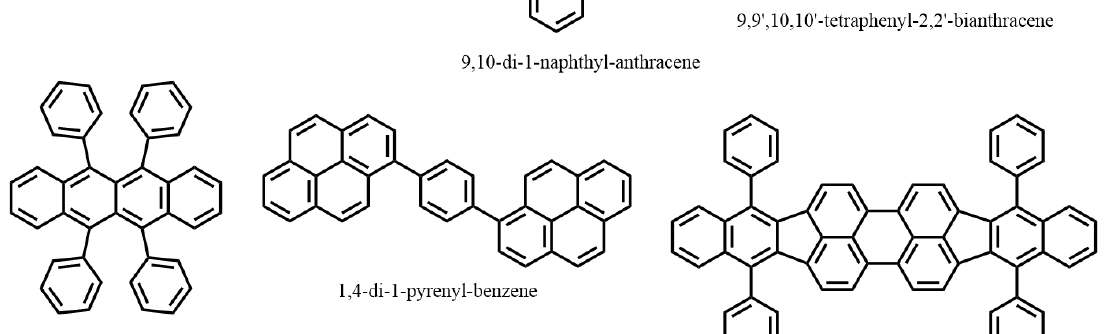
Figure 10. Aromatic molecules with bridging C al -C al linkages 1,3-di-(1pyrenyl) propane, which is linked by an aliphatic propyl group. This molecule eluted in the Aro-3 fraction. Figure 11. Examples of aromatic molecules that eluted to the Aro-3 fraction that would have other- wise eluted in the Aro-2 fraction if the heteroatoms were replaced by carbon atoms. (The green color designates sulfur atom, the blue color—NH group, and the red color—oxygen atom.)